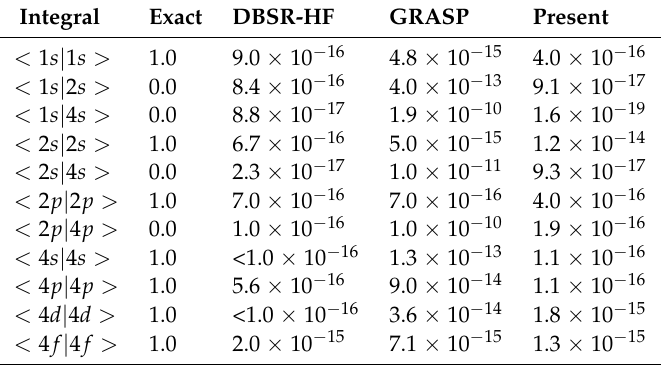
Table 1. Errors in present results for overlap integrals for hydrogenic orbitals from calculations with c = c au × 10 5 compared with GRASP and